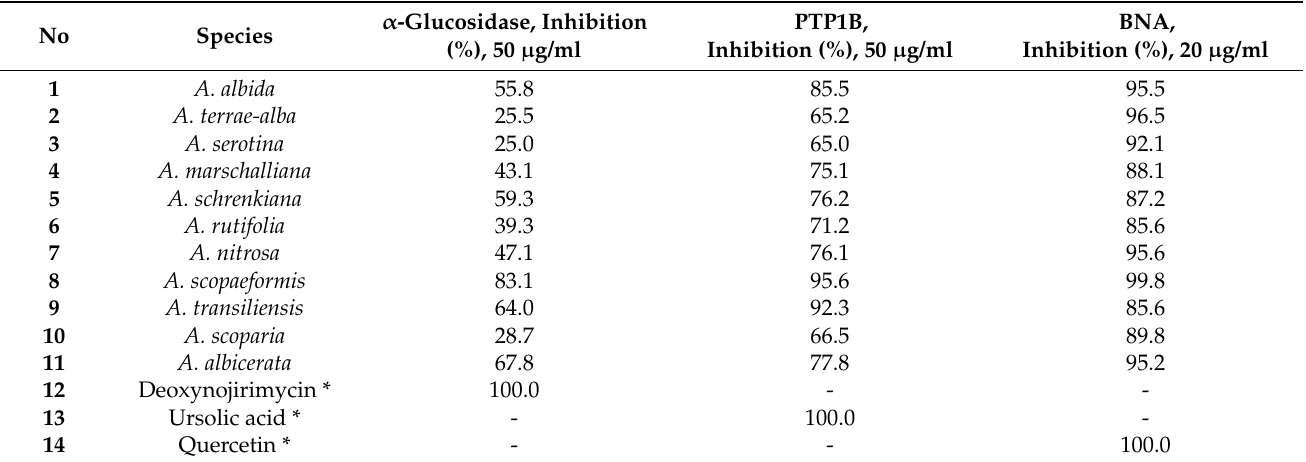
Table 4. Enzymatic activities of Artemisia